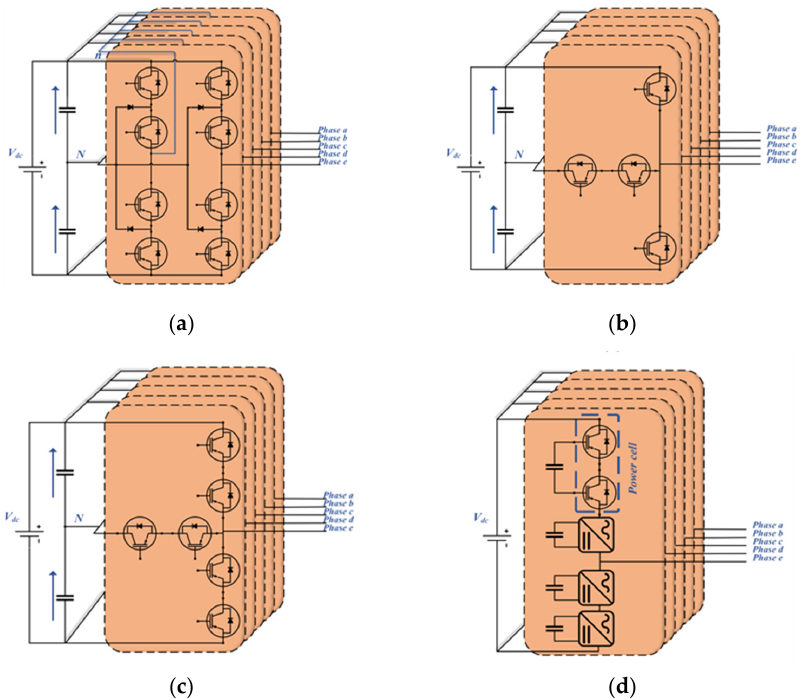
Figure 15. More topologies for five-phase drives: ( a ) 5L-HNPC; ( b ) 3L-NPP; ( c ) 4L-NPP; ( d ) MMC.